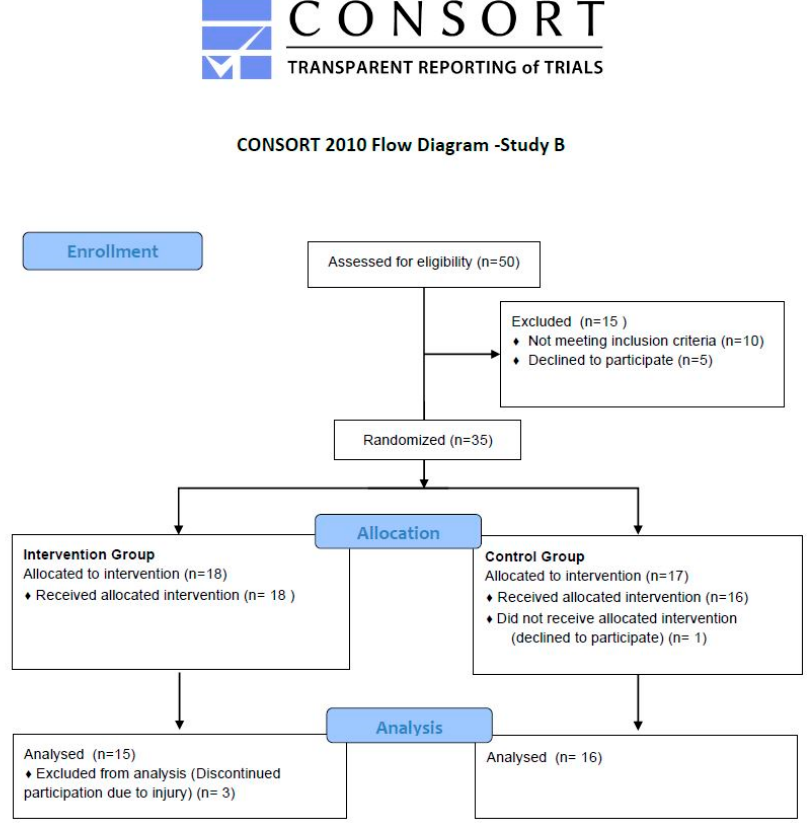
Figure 3. Consort fl ow diagram—Study B.